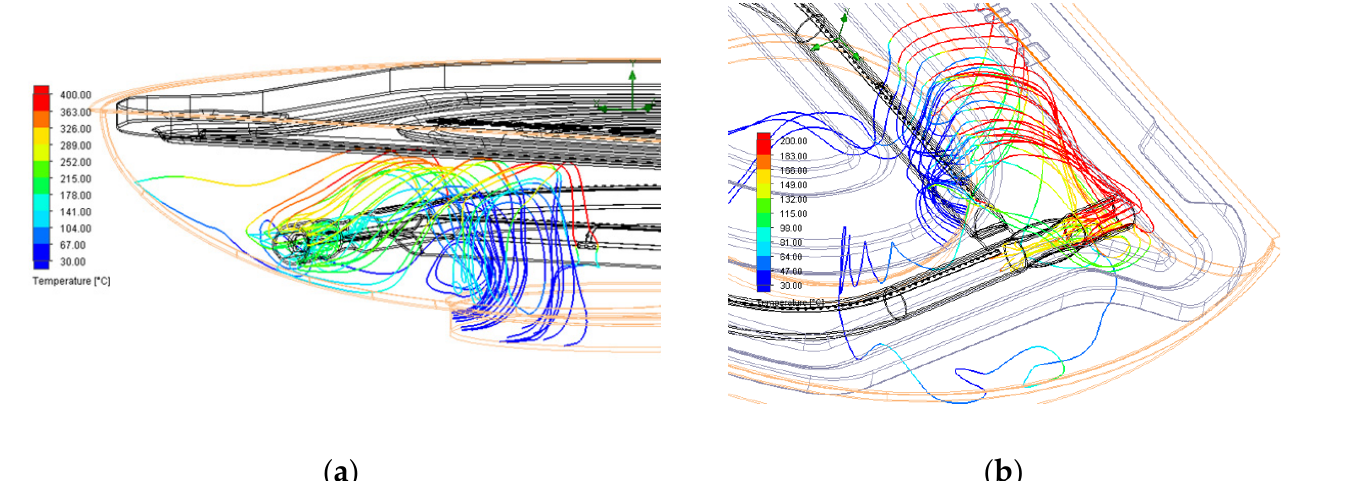
Figure 5. Air intake analysis of the original combustion tube. ( a ) Side and ( b ) front views of the first intake condition of the mixing tube.